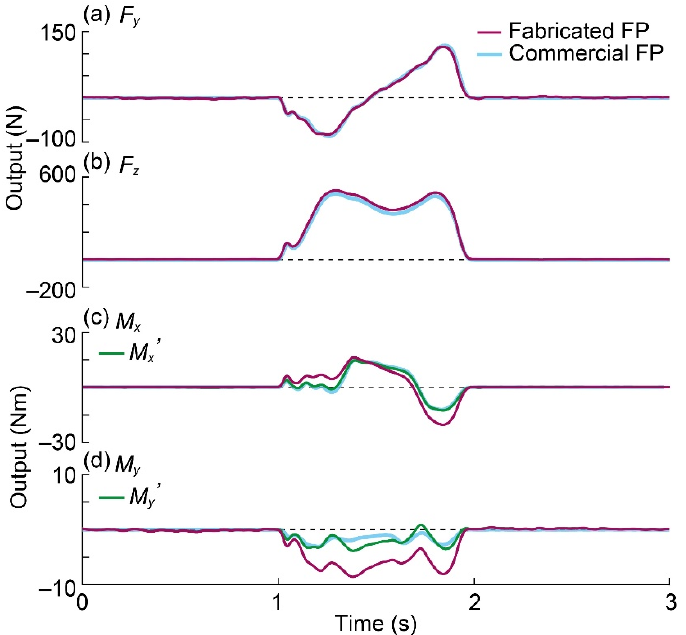
Figure 12. Measured GRF by the fabricated FP and commercial FP. ( a ) F y ; ( b ) F z ; ( c ) M x ; ( d ) M y . The x -axis moment around the center point of the commercial FP from the output of the fabricated FP is expressed in the following equation using fabricated height H of the FP. The moment in the y -axis of the fabricated FP can also be converted to a moment around the center point of the commercial FP using F x fab ; however, this is omitted because F x in normal walking is small.